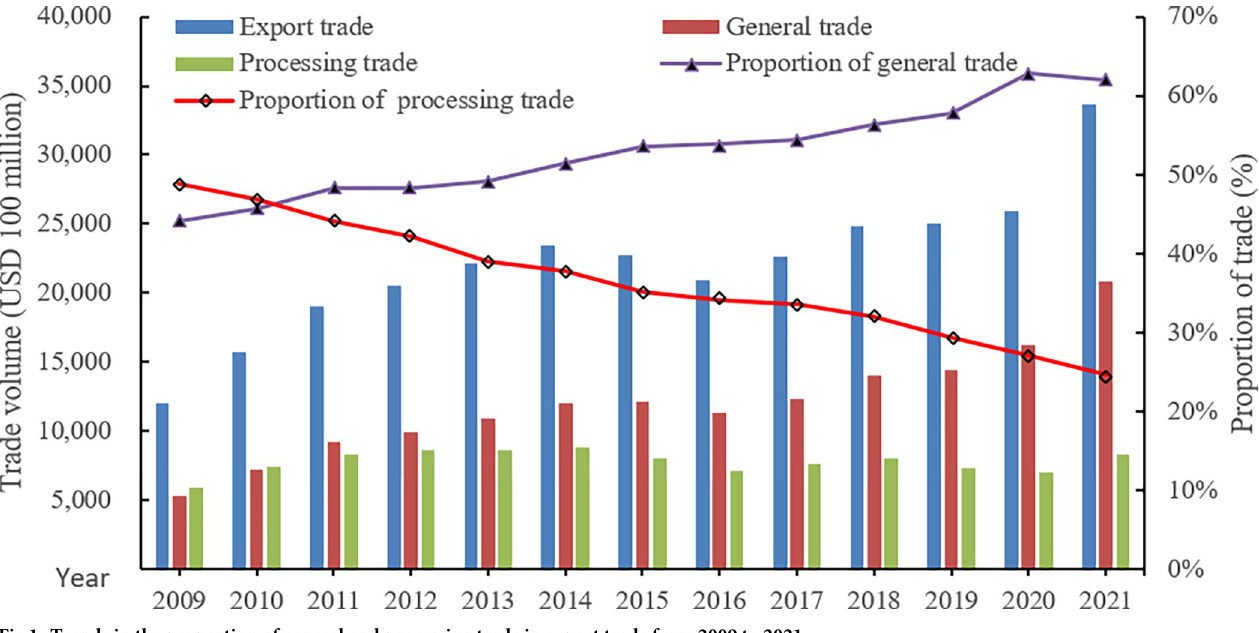
Fig 1. Trends in the proportion of general and processing trade in export trade from 2009 to